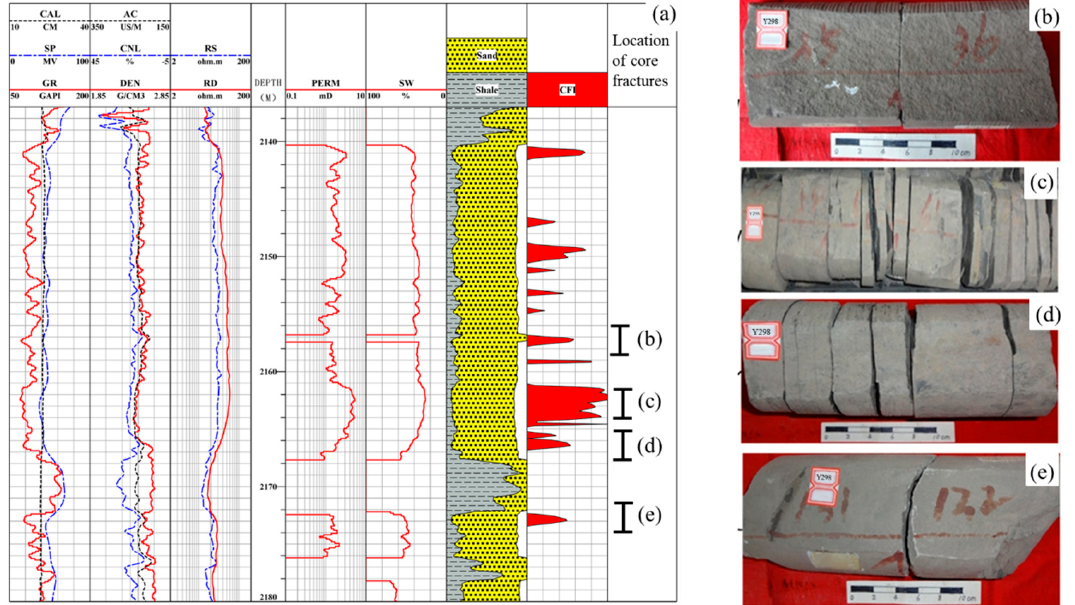
Figure 10. ( a ) Fracture identification effect of conventional logs in well Y298 (CAL, caliper; SP, spon-